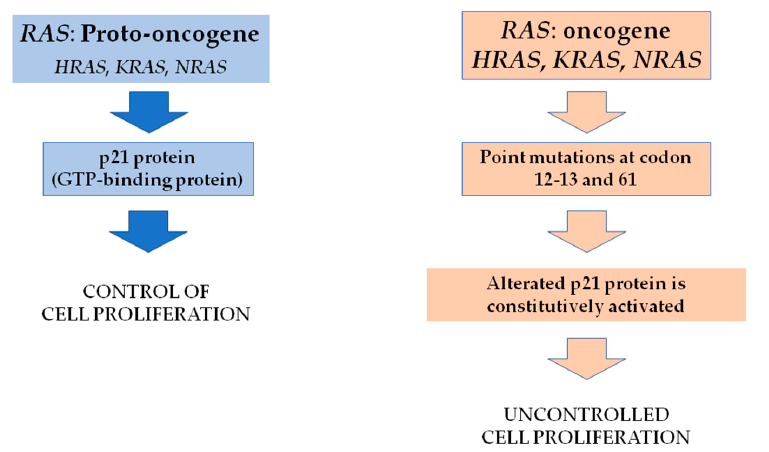
Figure 4. RAS gene activation in cancer: The RAS oncogene encodes for the p21 protein. In its native state, p21 controls cell growth and differentiation. When a point mutation occurs at codons 12, 13 and 61, p21 is constitutively activated, leading to uncontrolled cell